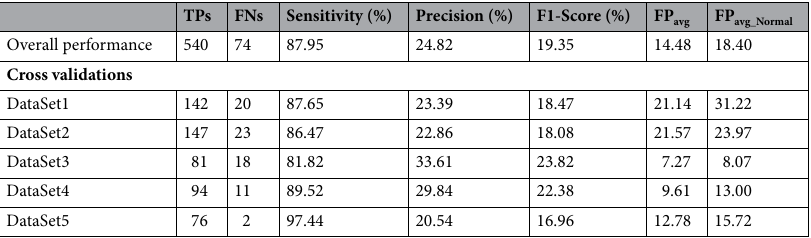
Table 1. Cross validation performances of DLA for BM detection using SPACE image. DLA deep learning algorithm, BM brain metastases, SPACE sampling perfection with application-optimized contrasts using